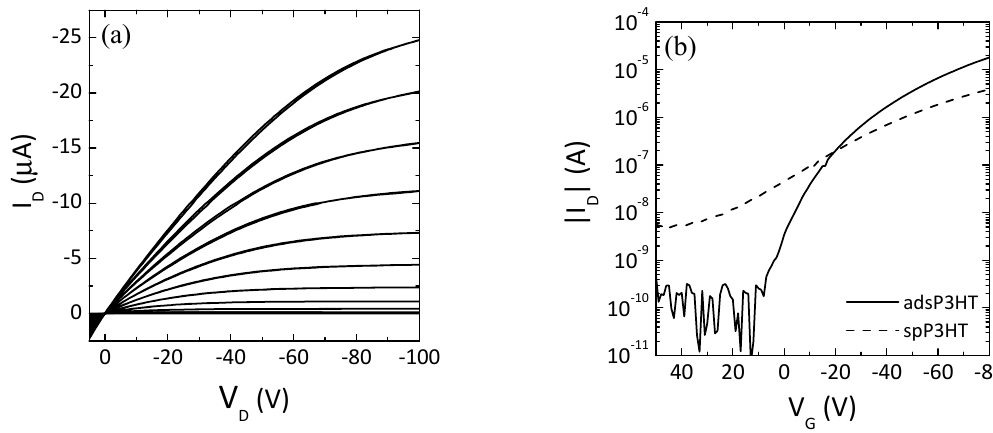
Figure 4. ( a ) Output and ( b ) transfer curves of adsP3HT TFT.